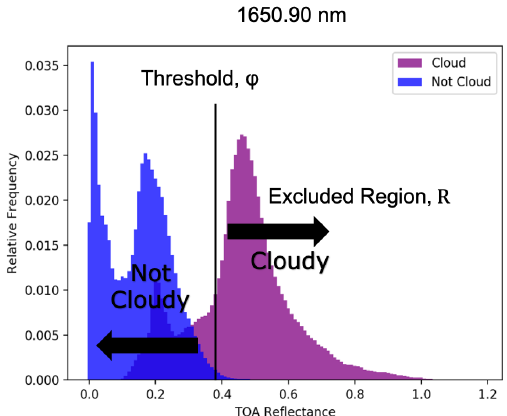
Figure 3. Depiction of the exclusion region used to classify cloud- contaminated data.